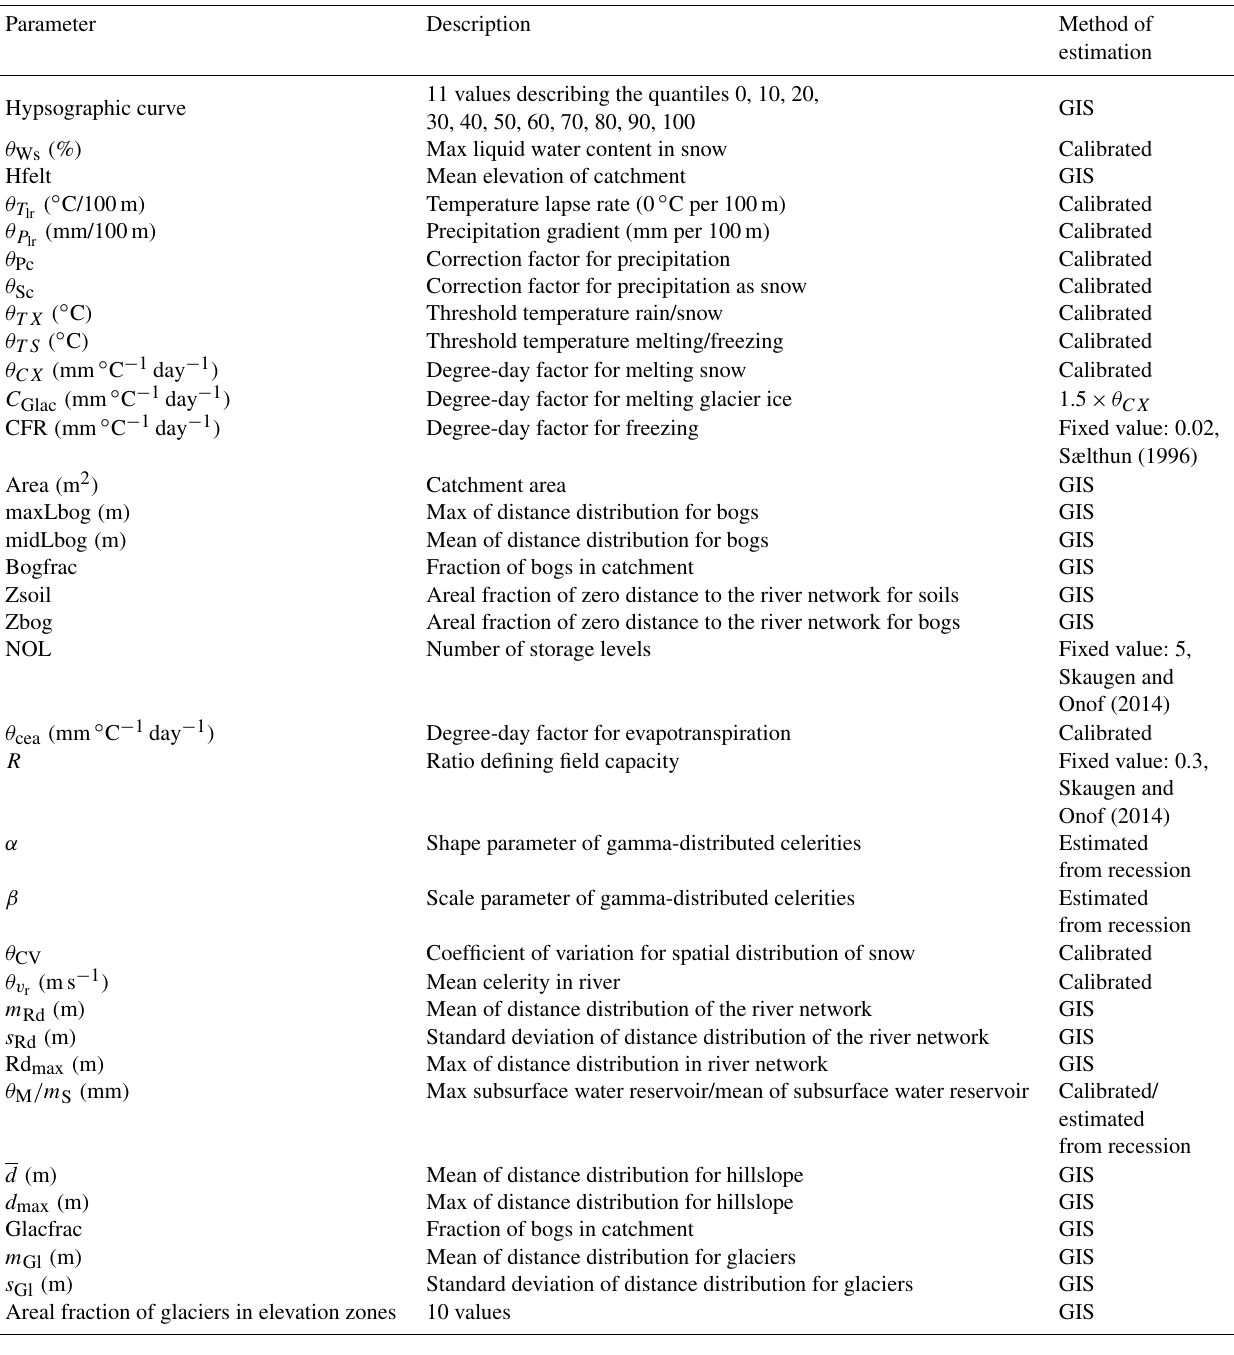
Table 1. Parameters of the DDD model with description and method of estimation. Some parameters have fixed values obtained through experience in calibrating DDD for gauged catchments in Norway. These values are within the recommended range for the HBV model (Sælthun, 1996). The GIS analyses are carried out using the national 25 × 25m DEM